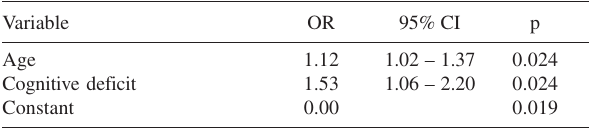
Table 7 - Cognitive loss – logistic